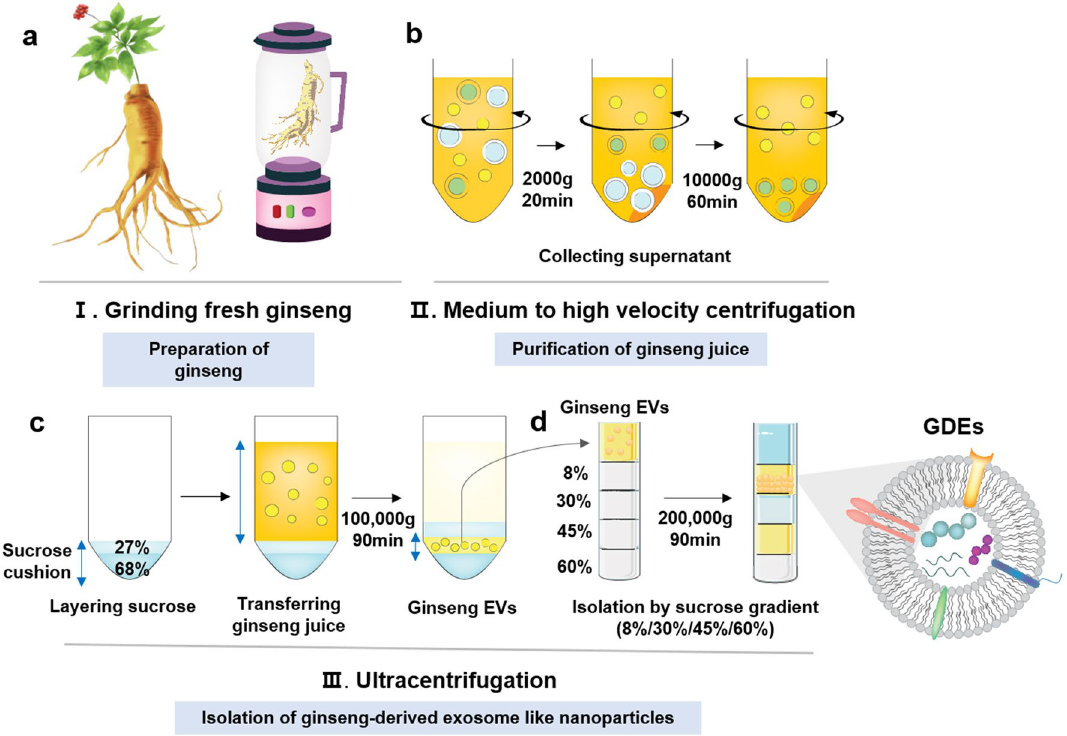
transferred to the bottle. After ultracentrifugation, the nanovesi- cles were collected between the sucrose cushions. d to isolate GDEs, the nanovesicles were purified using a sucrose gradient (8/30/45/60%). GDEs were obtained between the 8% and 30% sucrose